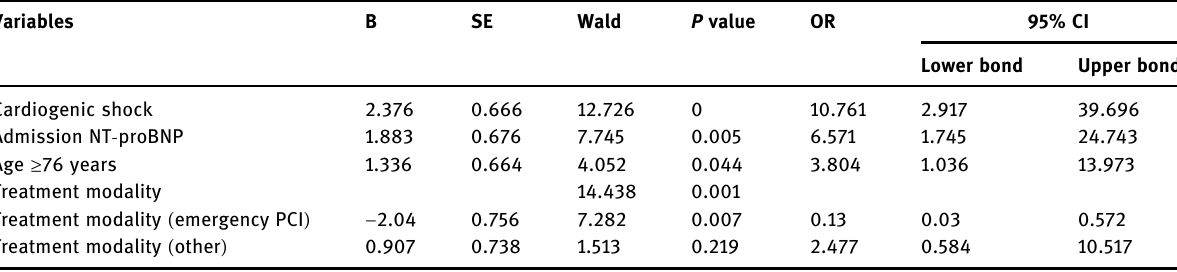
Table 5: Logistic regression analysis of mortality risks in STEMI patients